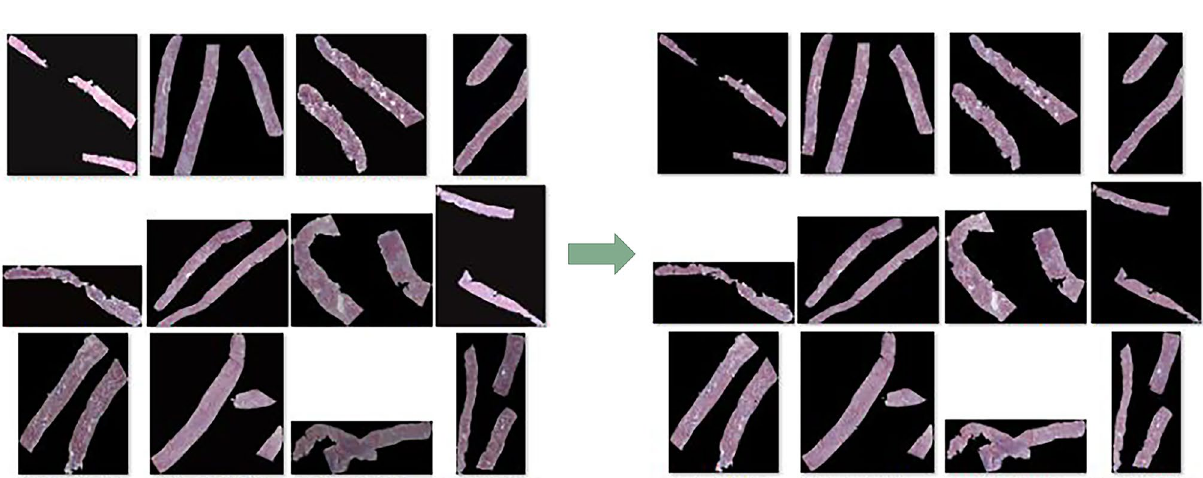
Figure 1. Workflow for the unsupervised learning using a bag-of-words paradigm. In step (1) the cortex part of the biopsy sample was used; (2) the Reinhard stain color normalization method applied; (3) each biopsy sample image was tiled into 256 × 256 pixel patches; (4) we extracted features from each patch using the transfer learning method in deep learning; (5) unsupervised machine learning algorithms called K-means clustering was applied; and finally (6) a histogram representation for each biopsy sample was created to describe the distribution of each type of cluster at the patient level.